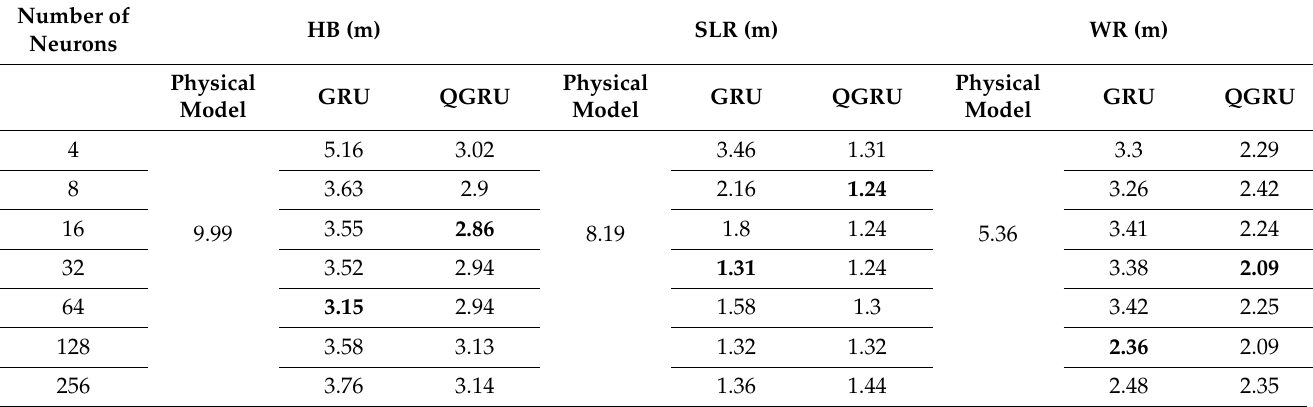
Table 2. Comparison between the QGRU and GRU on each scenario of the vehicle localisation task.